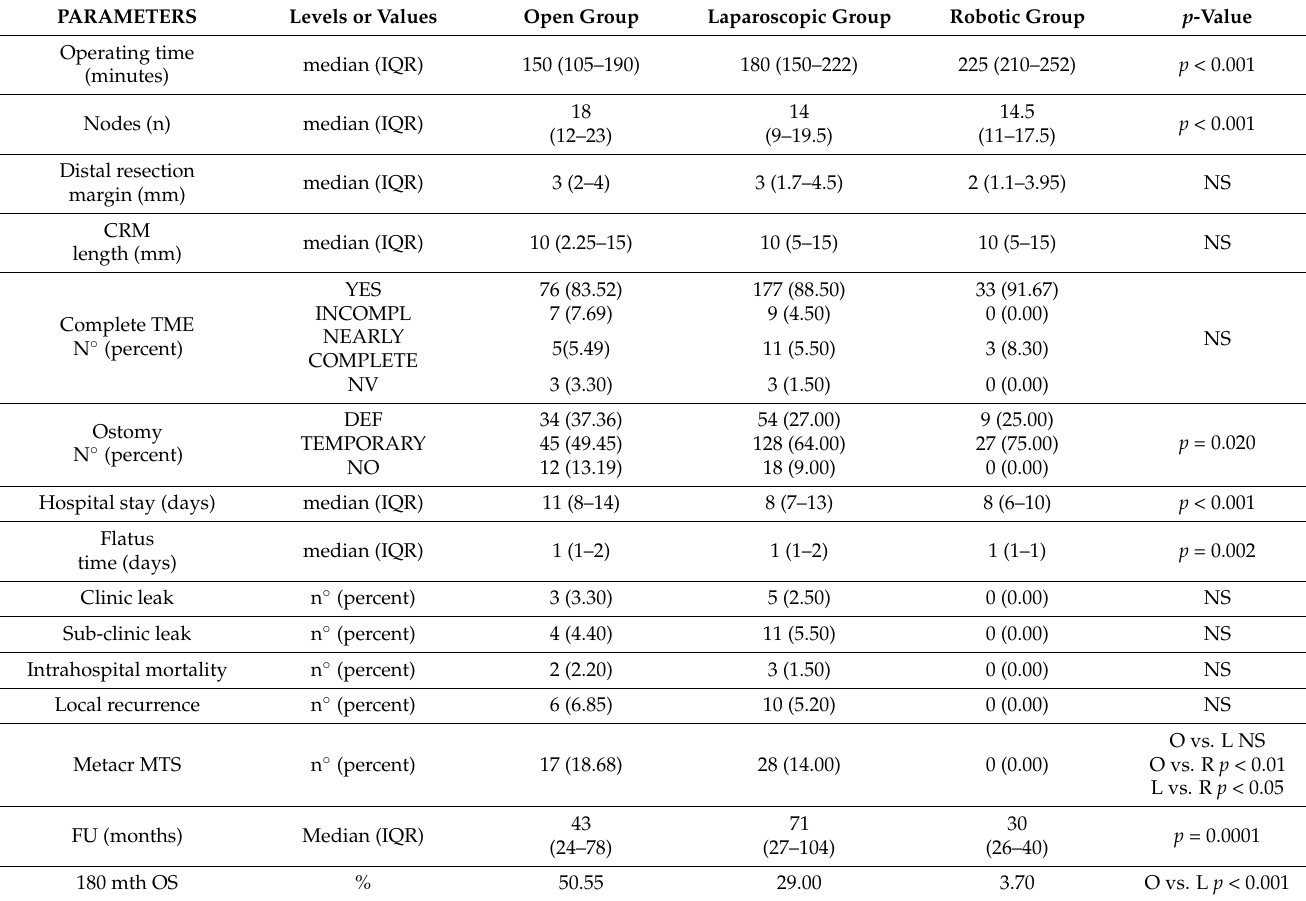
Table 2. Surgical, clinical and survival outcomes of the described case